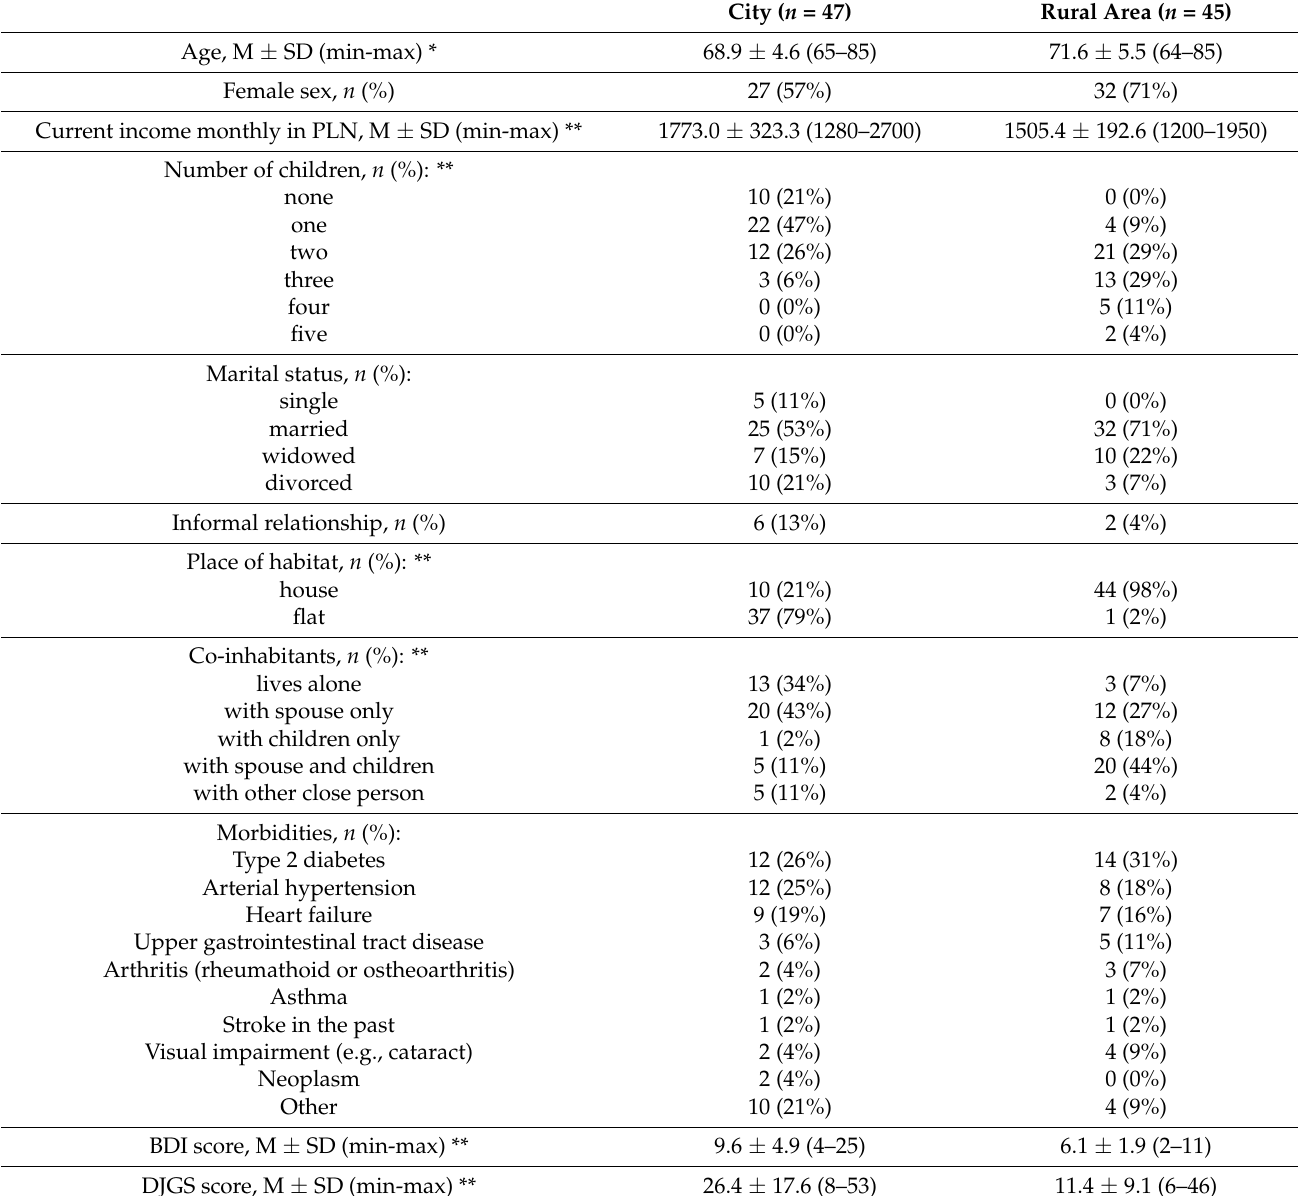
Table 1. Characteristics of the studied group of older adults, with a comparison between groups delineated by the place of residence (city or rural